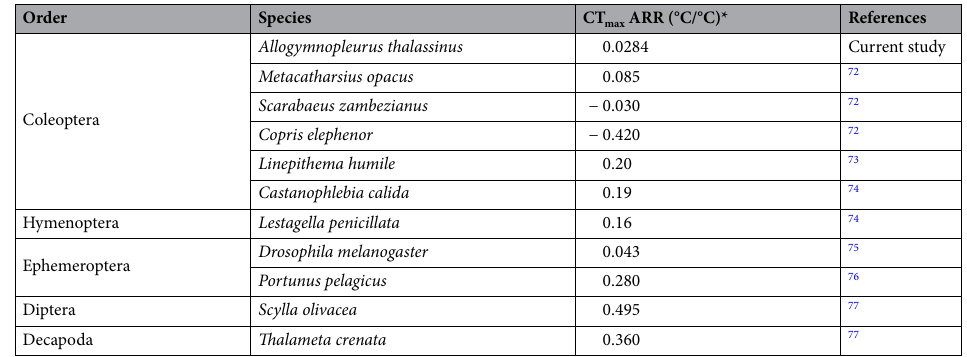
Table 5. The critical thermal maxima (CT max ) acclimation response ratios (ARR) for A. thalassinus compared to other different Orders and their specific species obtained from literature. The list may not be purely exhaustive but represents a significant number of studies found in literature at the time of publication. Also note that CT max values and consequently ARRs may vary depending on CT max methodological context e.g. starting temperature 17 . All the acclamatory response ratio values were calculated only for CT max at ramping rate of 0.25